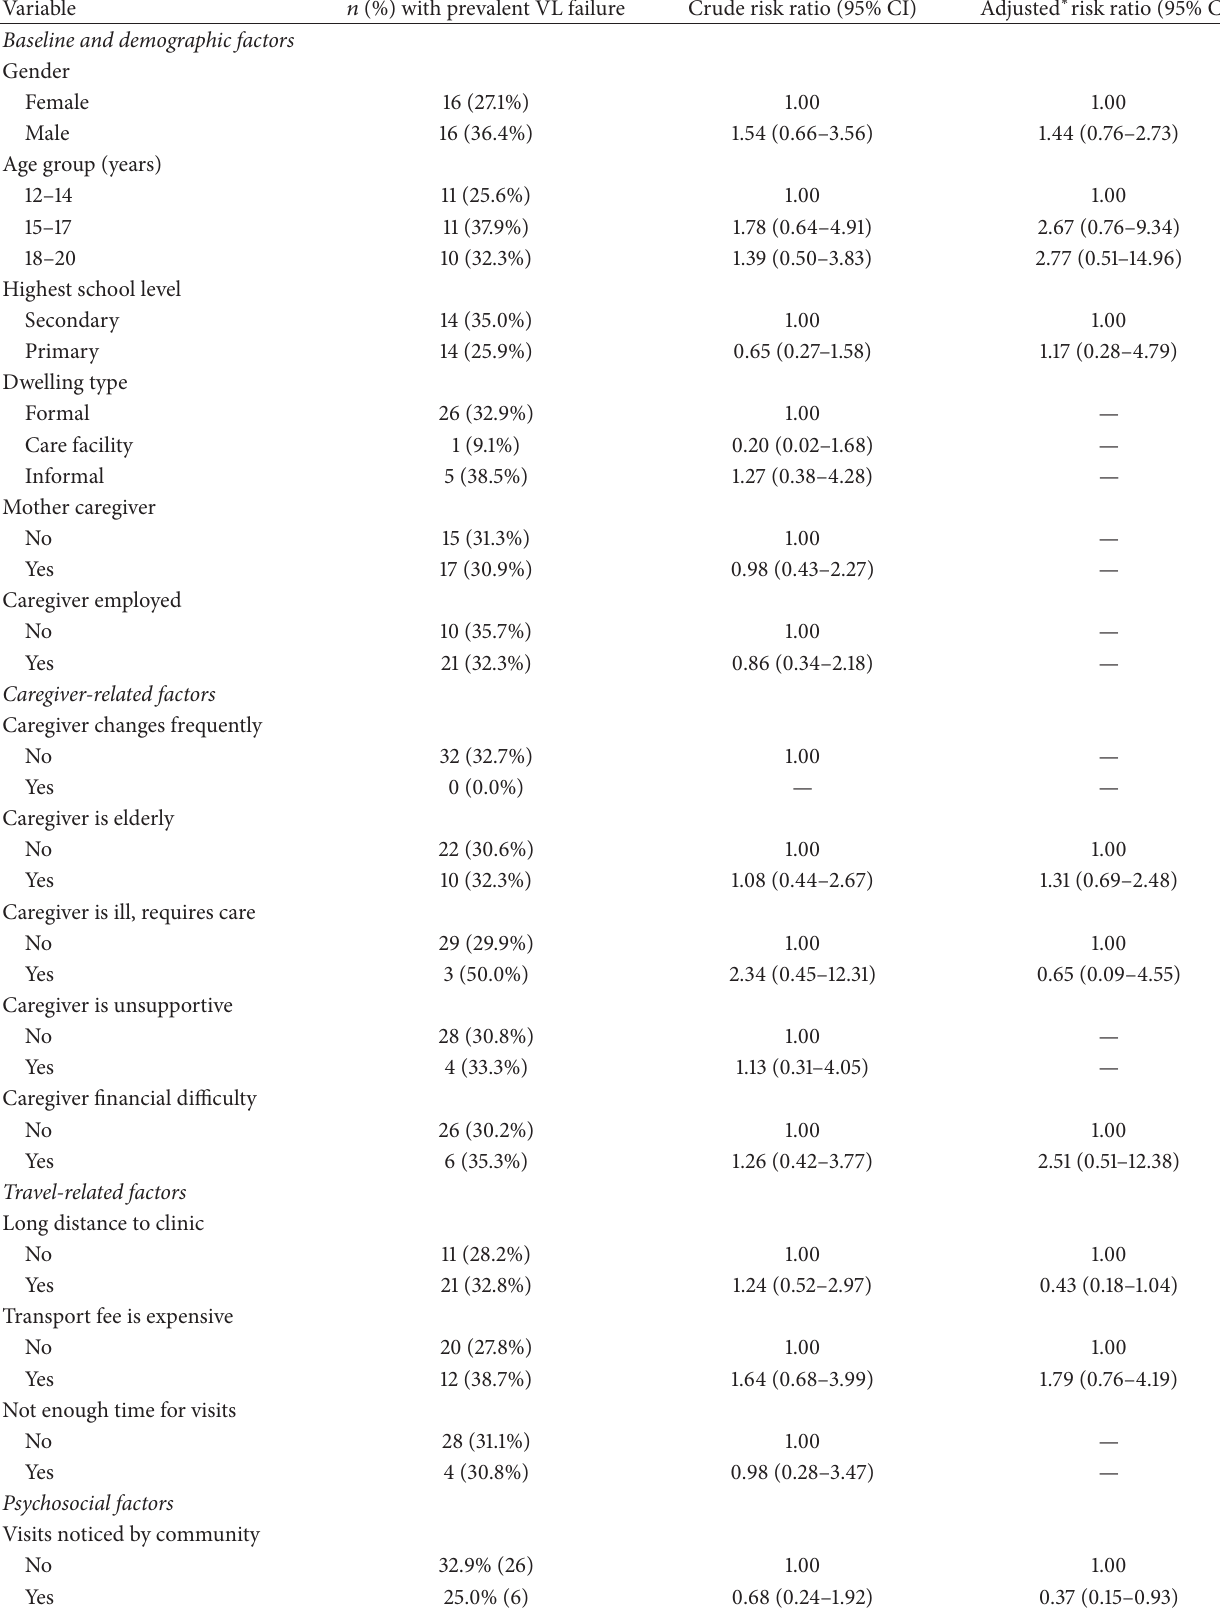
Table 4: Factors associated with prevalent virologic failure among adolescents with a recorded VL measurement (𝑛 = 103) .